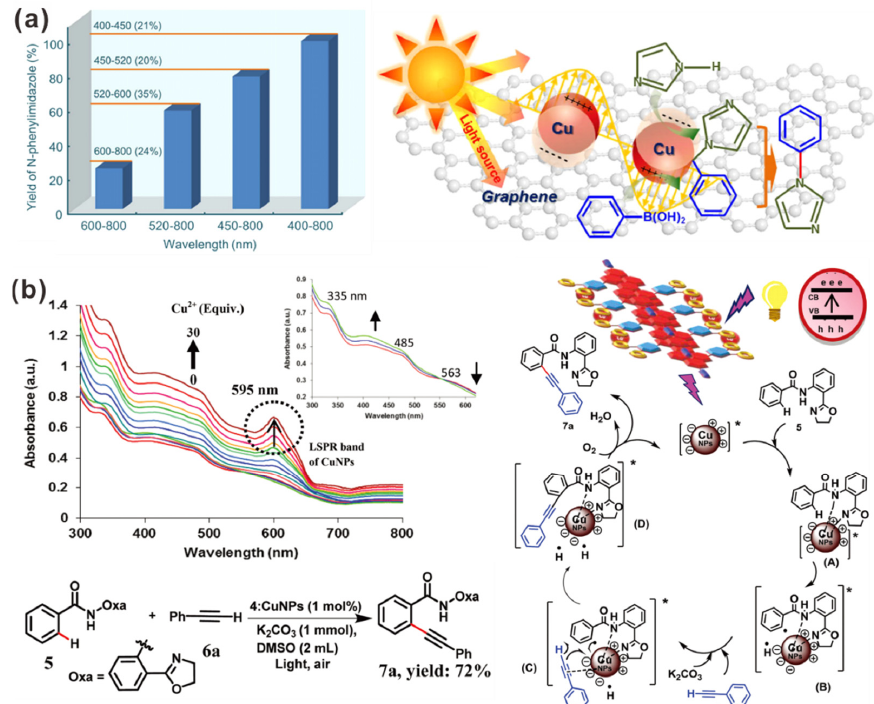
Figure 16. Plasmonic CuNPs with other support materials for photocatalysis. ( a ) Cu/graphene for photocatalytic C-N cross-coupling reaction. Reproduced with permission from Reference [147]. Copyright 2015 Nature Publishing Group. ( b ) Supramolecular ensemble 3:CuNPs for photocatalytic C-C cross-coupling by C(sp 2 )-H functionalization. Reproduced with permission from Reference [148]. Copyright 2016 Royal Society of